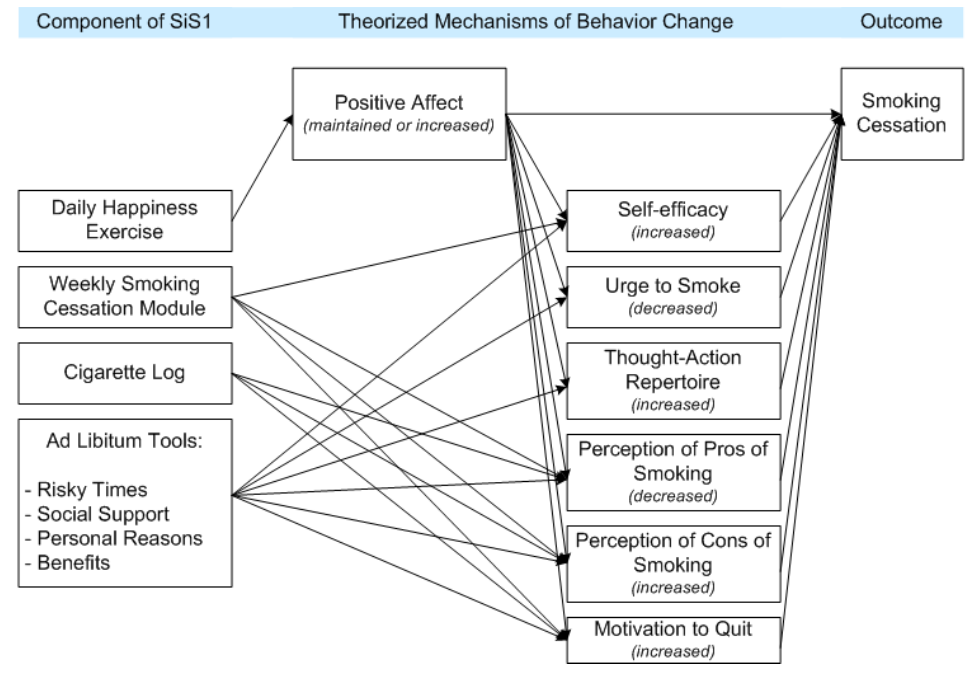
Figure 1. Conceptual model of how SiS1 was theorized to support smoking